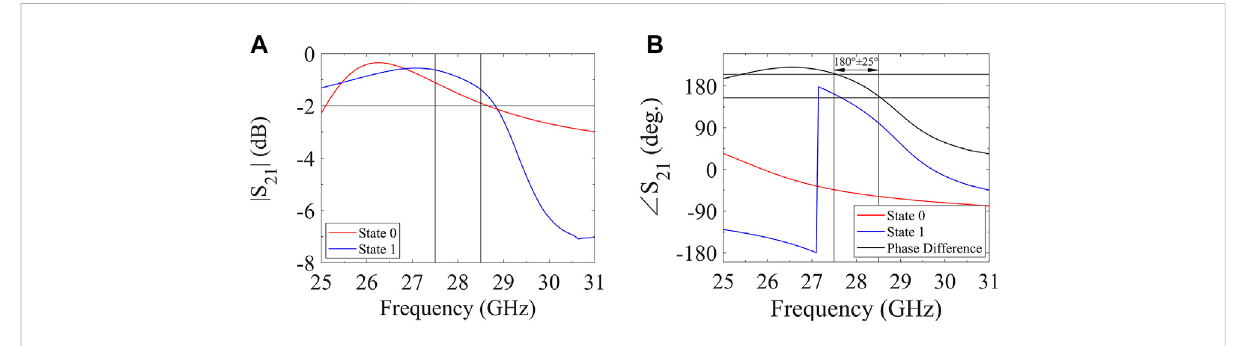
FIGURE 2 (A) The transmission amplitude and (B) transmission phase of two digital states.